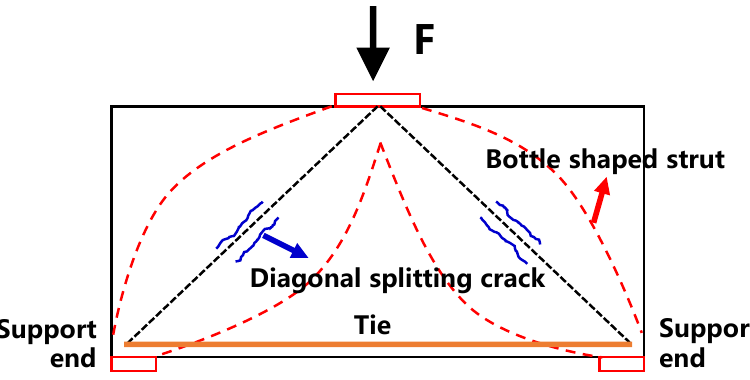
Figure 11. STM in simply supported deep beam.